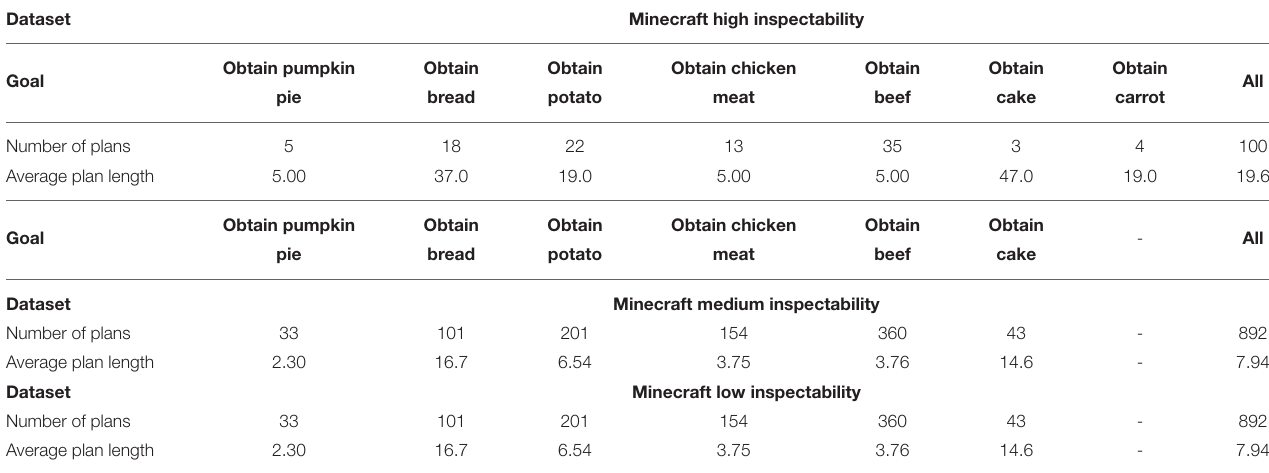
TABLE 1 | Metrics and measures for the three Minecraft datasets used in our experiments.